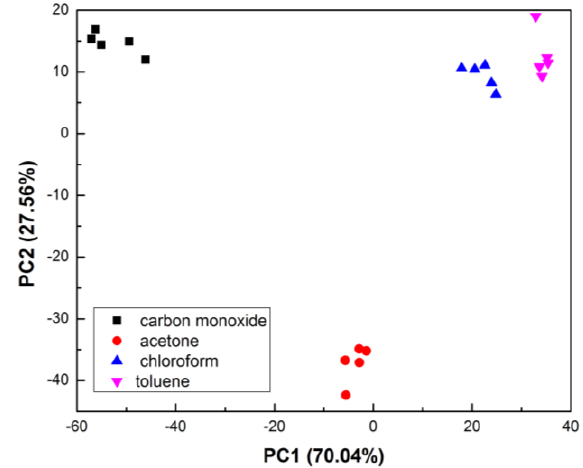
Figure 9. PCA score plots of carbon monoxide, acetone, chloroform and